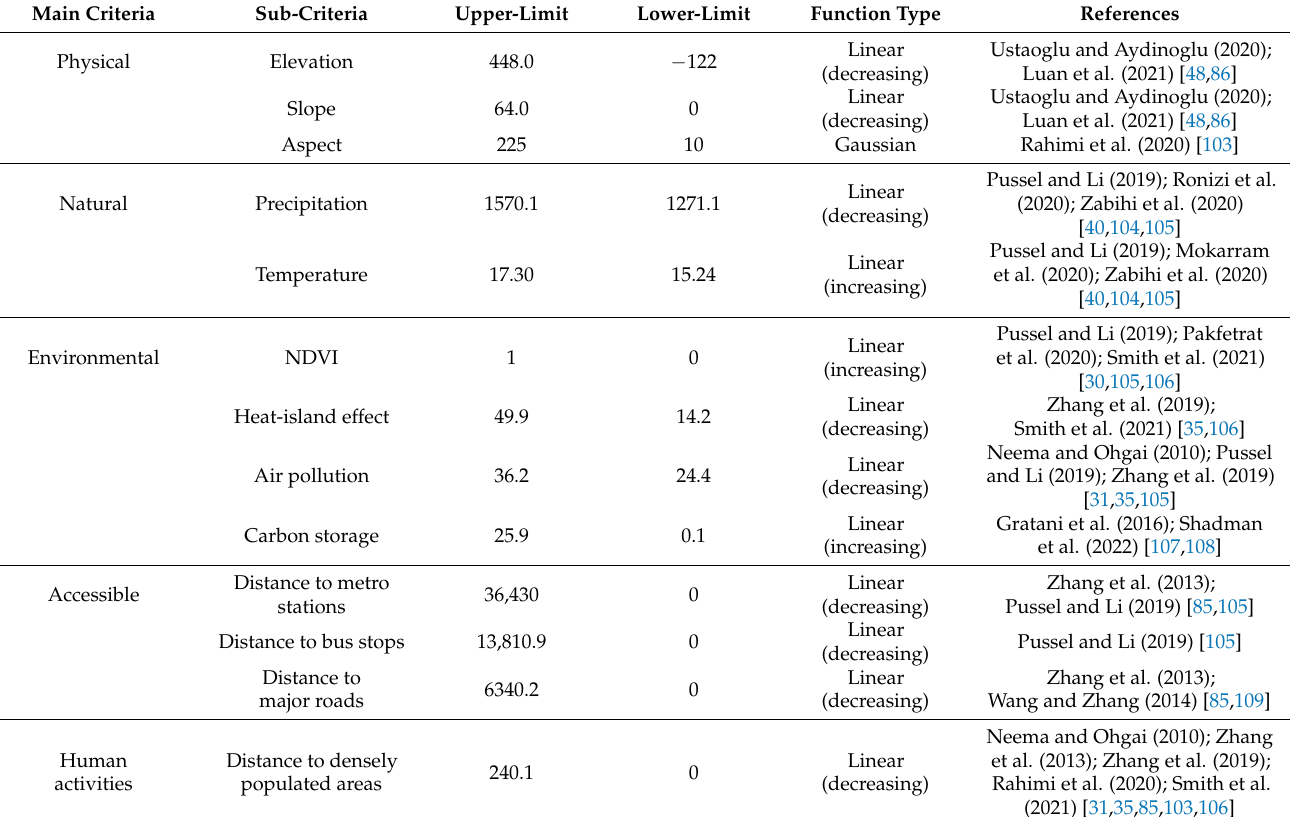
Table 1. The evaluation criteria for city park site selection with fuzzy membership